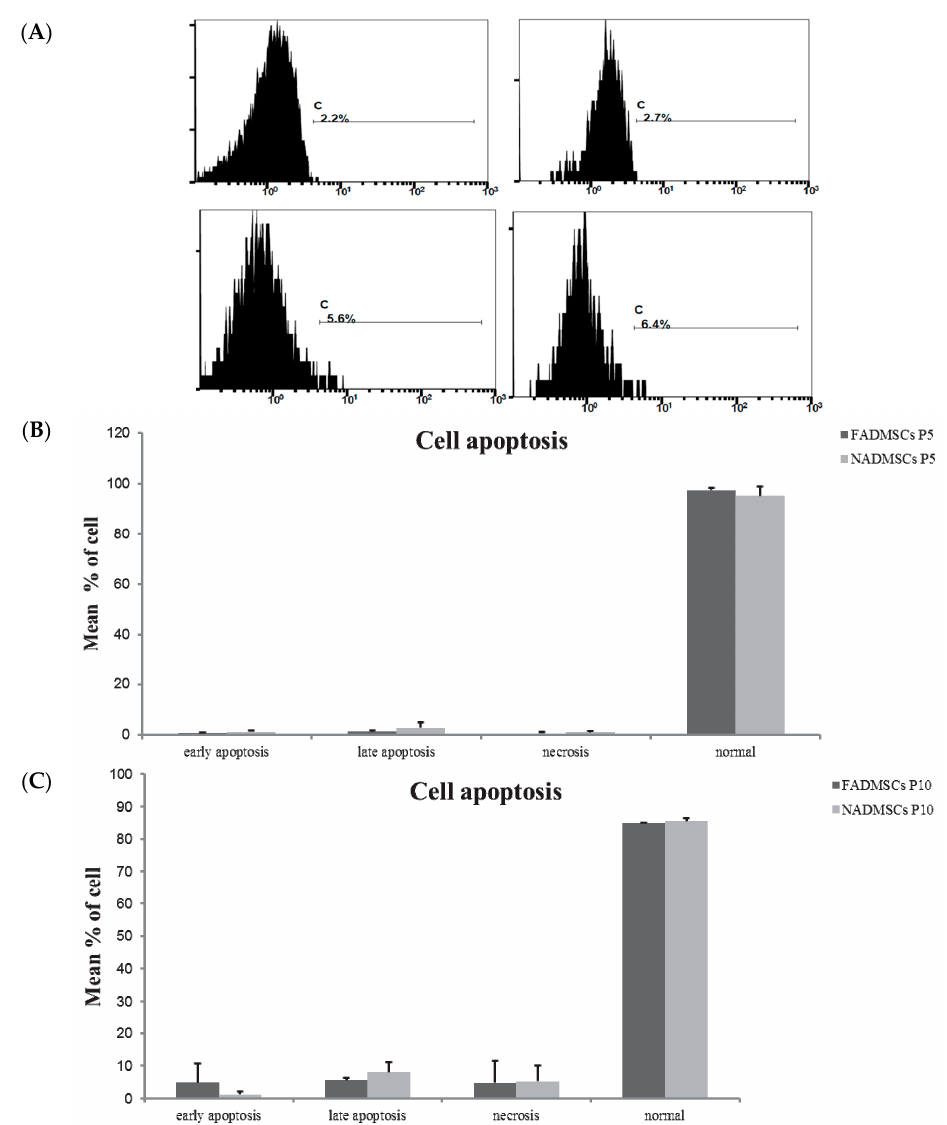
Figure 3. Apoptosis rates in ALF-derived ADMSCs and normal ADMSCs determined via